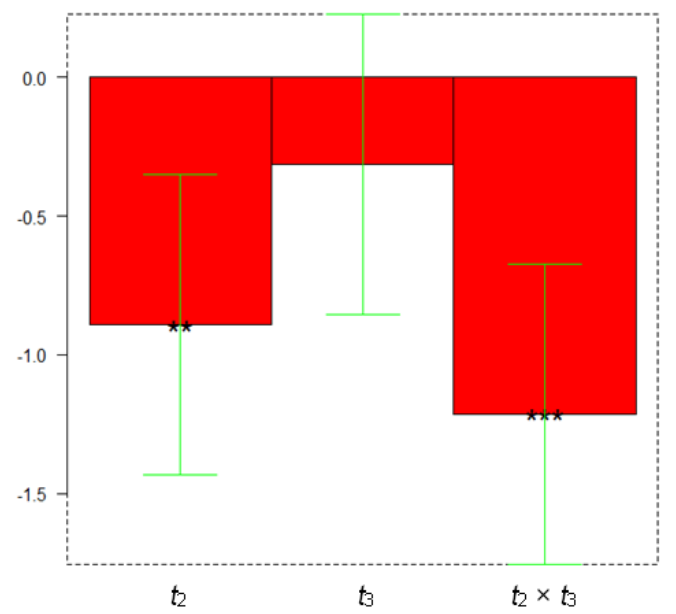
Figure 1. Experimental design to optimize the reaction times of the two functionalization steps of the working gold electrode: coefficients plot. The greatest values and little black stars (regardless of the sign) may suggest a significant influence of the respective parameter or interaction.